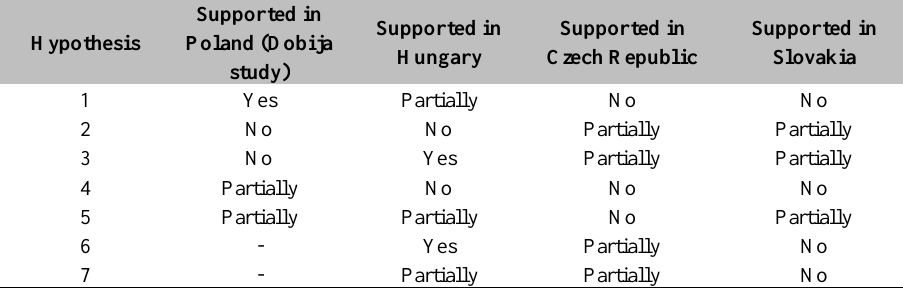
Table 4 – Comparison of results in countries of